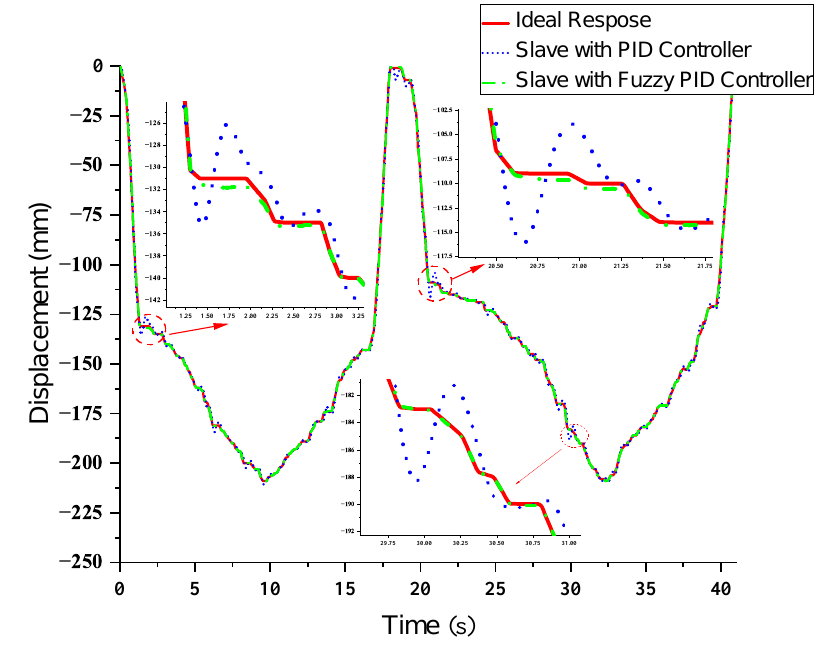
Figure 10. Displacement performance under PID and fuzzy PID. The master of VISR was moved randomly, and the slave manipulator response